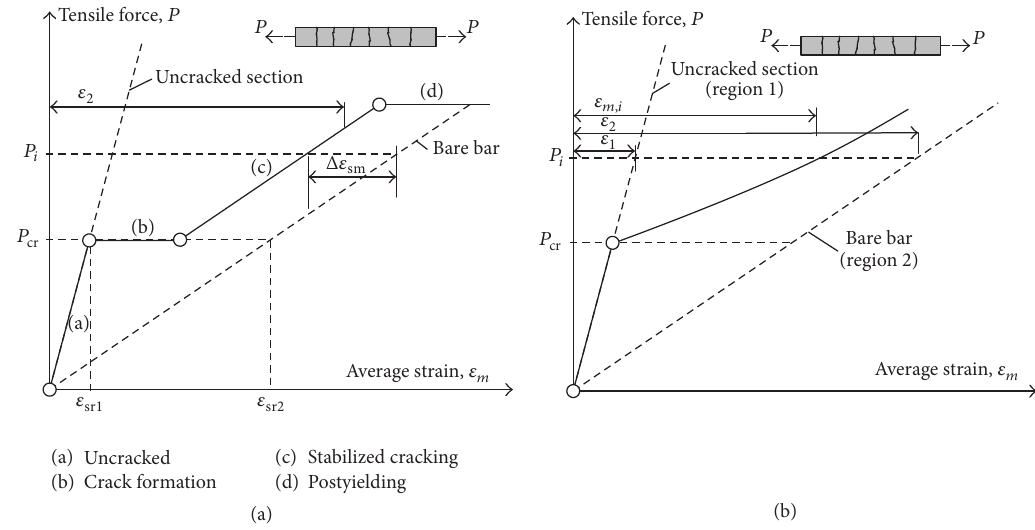
Figure 6: Load-average strain models according to Model Code 1990 [10] (a) and Model Code 2010 [11] (b).